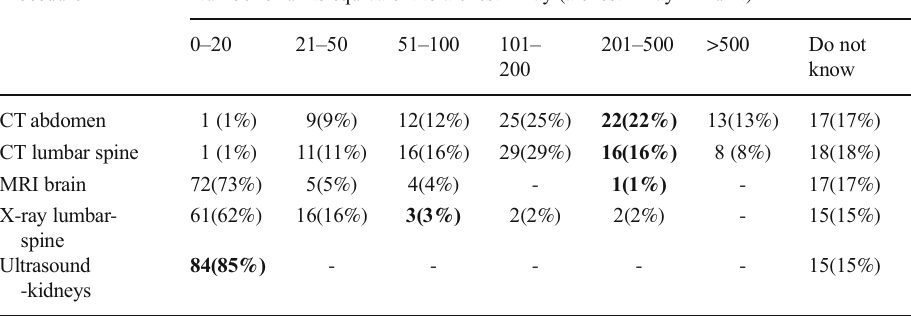
Table 4 Frequency distribution of responses to different level of radiation ( n =